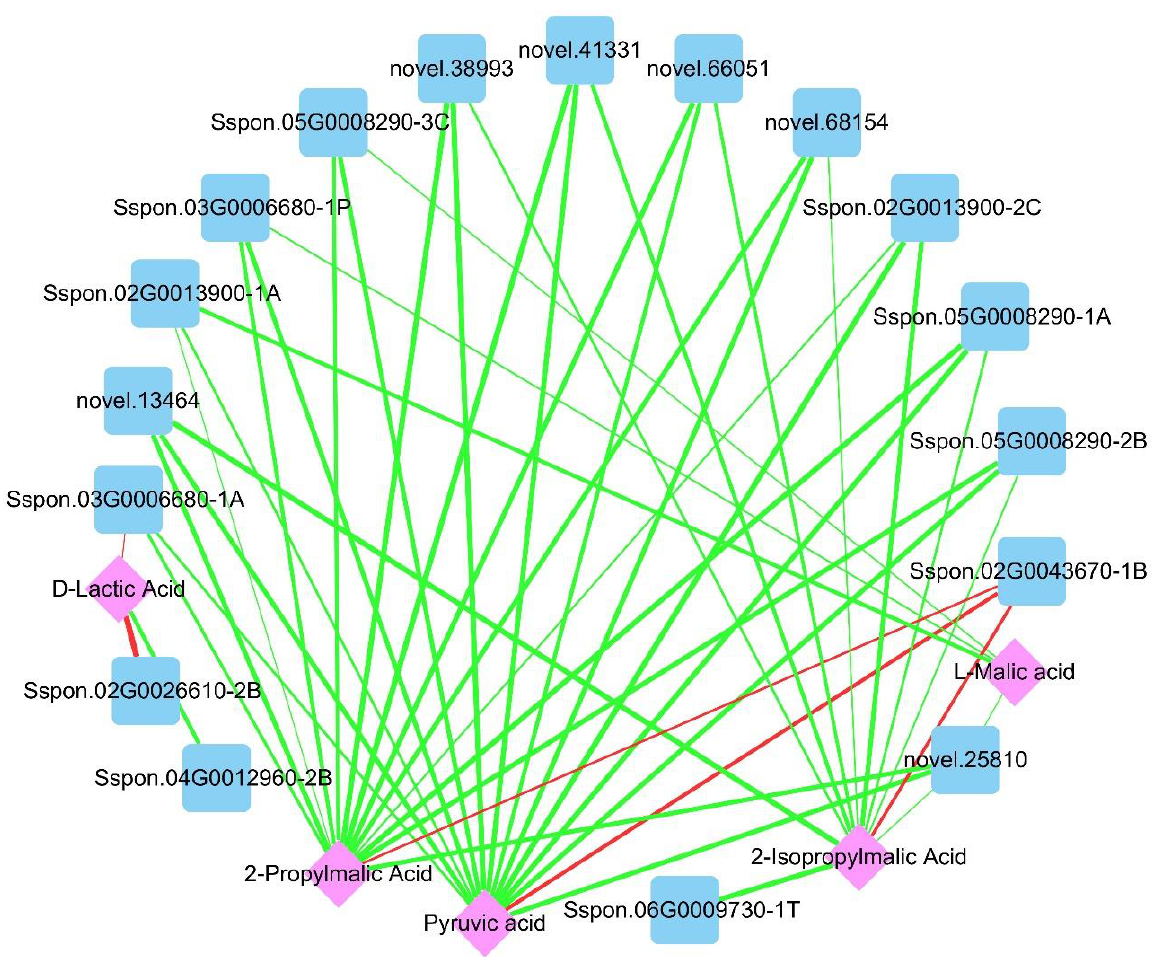
Figure 6. Gene-metabolite network of pyruvate metabolism for the CG/DS comparison (|r| ≥ 0.990). Blue squares and pink diamonds represent genes and metabolites, respectively. Green lines indicate negative correlations and red lines are positive correlations. The line thickness represents the magnitude of the correlation coefficient, which ranged from 0.990 to